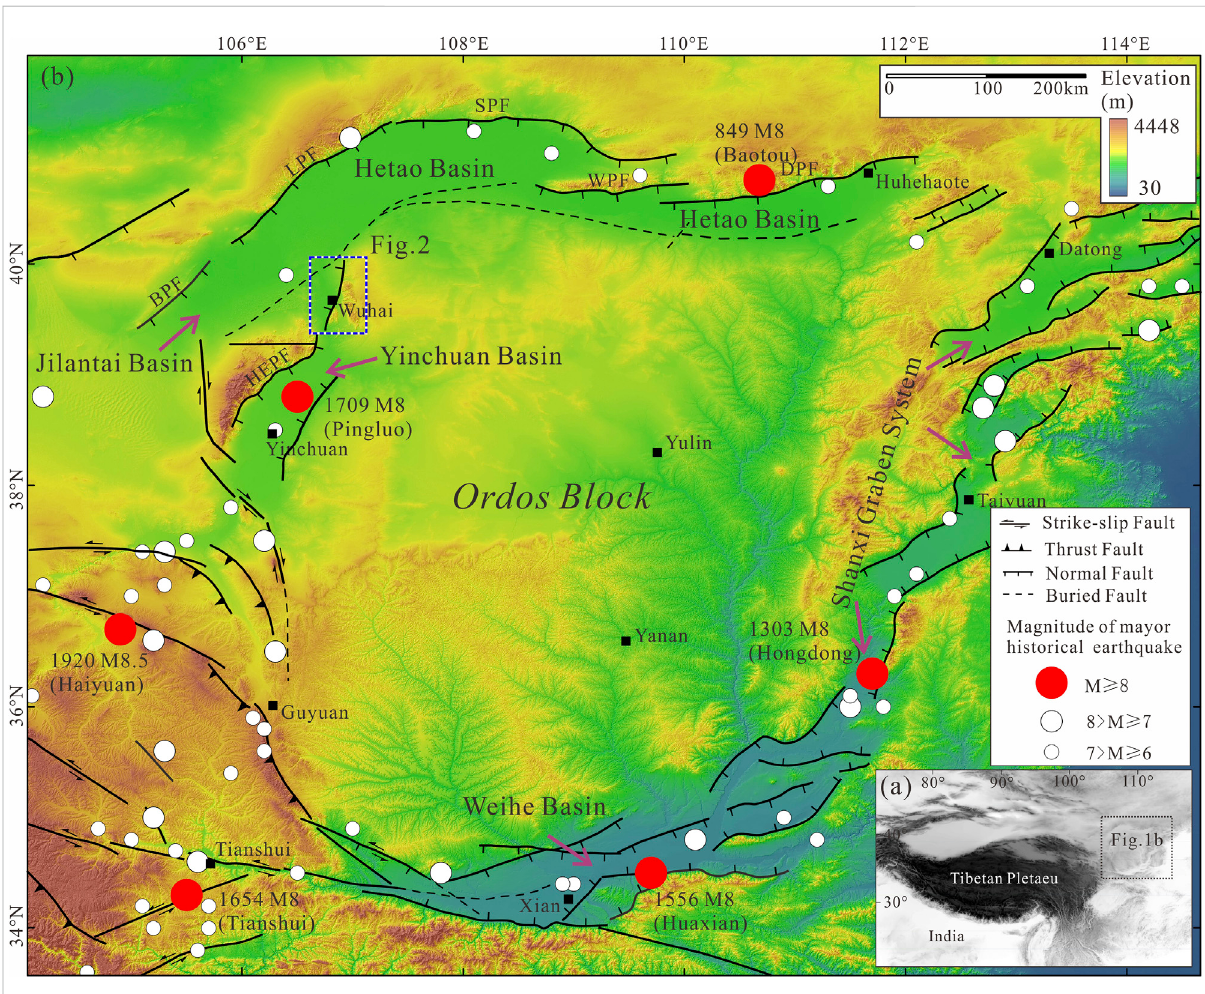
FIGURE 1 (A) Location of the Ordos Block. (B) Color-shaded relief map showing the distribution of large historical earthquakes and major active faults around the Ordos Block. The blue dashed rectangle shows the location of Figure 2. Abbreviations of names of active faults: DPF, Daqingshan Piedmont Fault; WPF, Wulashan Piedmont Fault; SPF, Seertengshan Piedmont Fault; LPF, Langshan Piedmont Fault; BPF, Bayanwulashan Piedmont Fault; HEPF, Helanshan East Piedmont